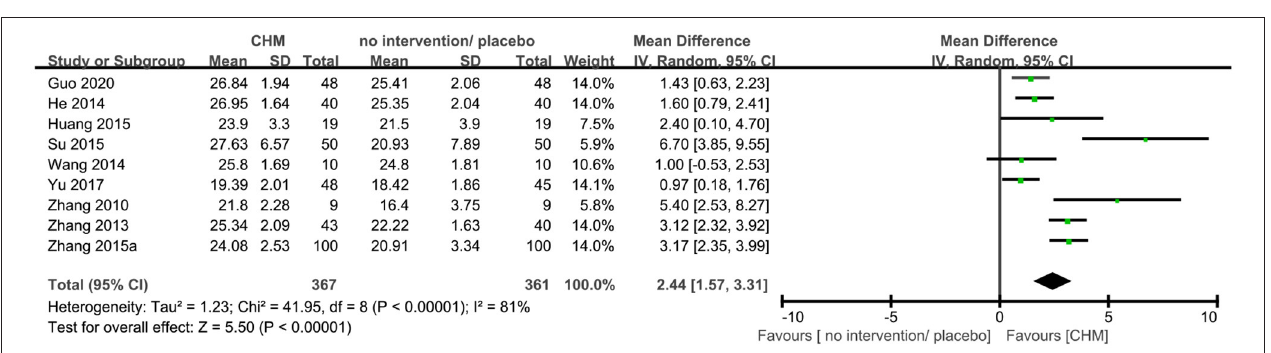
Frontiers in Neurology | www.frontiersin.org 11 June 2022 | Volume 13 | Article